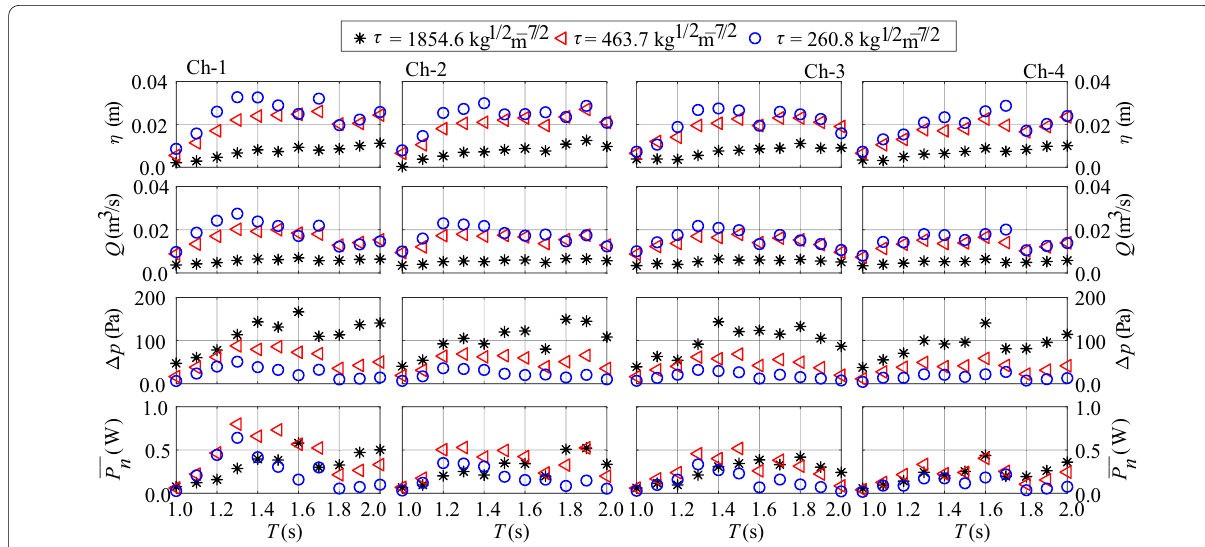
Figure 10 Impact of PTO damping on the water surface elevation η (1st row), airflow rate Q (2nd row), the differential air pressure p (3rd row), and the pneumatic power P n (4th row) at constant wave height ( H